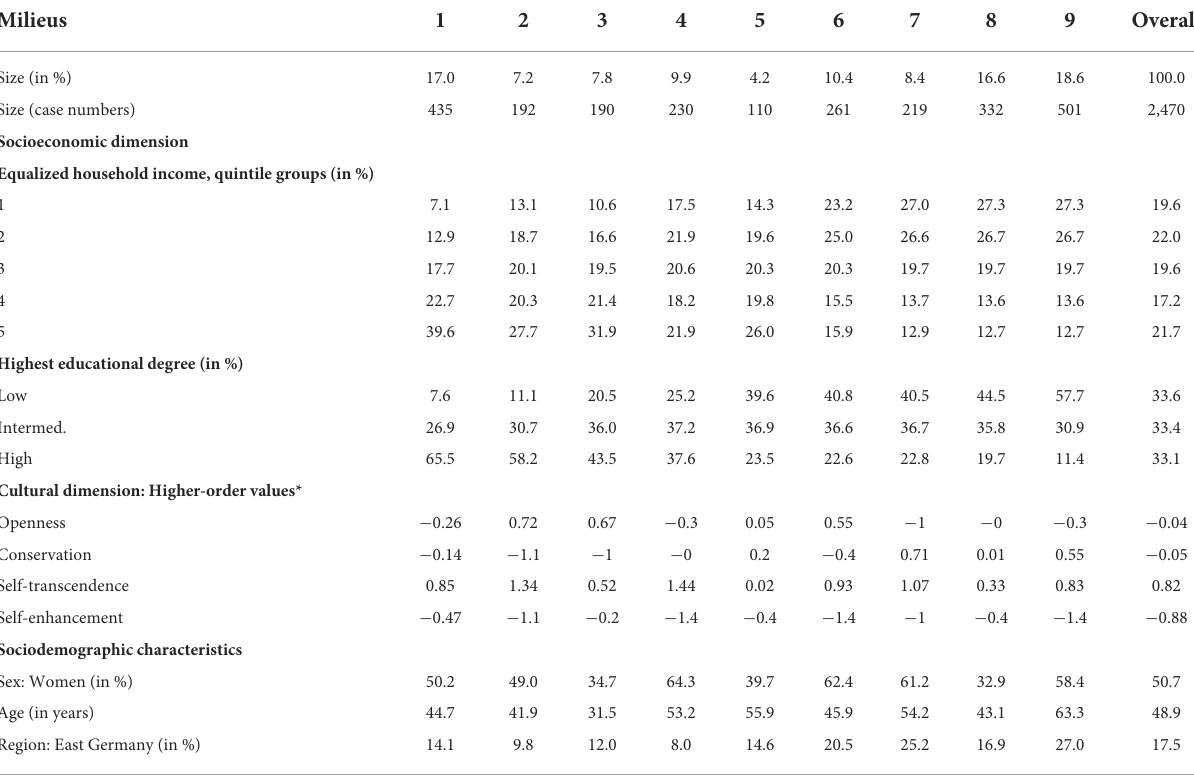
TABLE 1 A model of social milieus: Latent Class Analysis of socioeconomic position and basic human values. Milieus 1 2 Overall